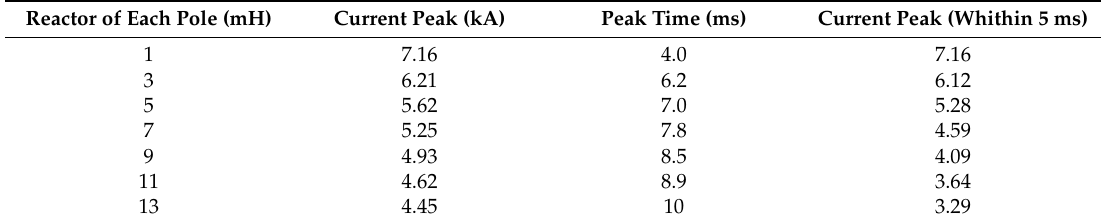
Table 6. Discharge current I 1 under different current limiting reactor of converter station I. Reactor of Each Pole (mH)